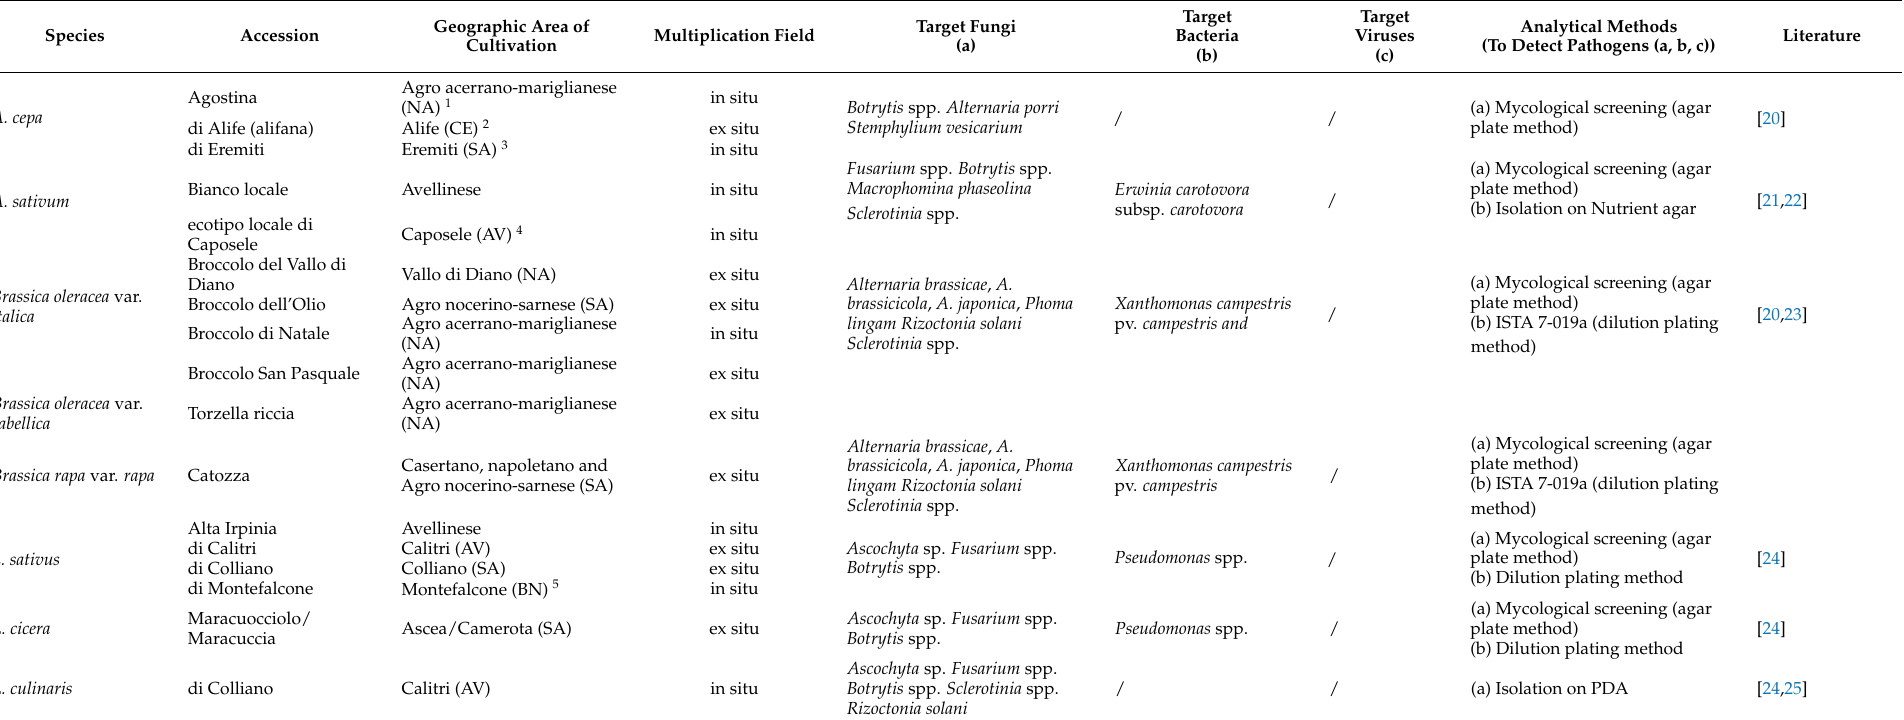
Table 1. List of accessions subjected to surveillance for seed health. Species, accession name, geographic area of cultivation, fungi, bacteria, and viruses searched.